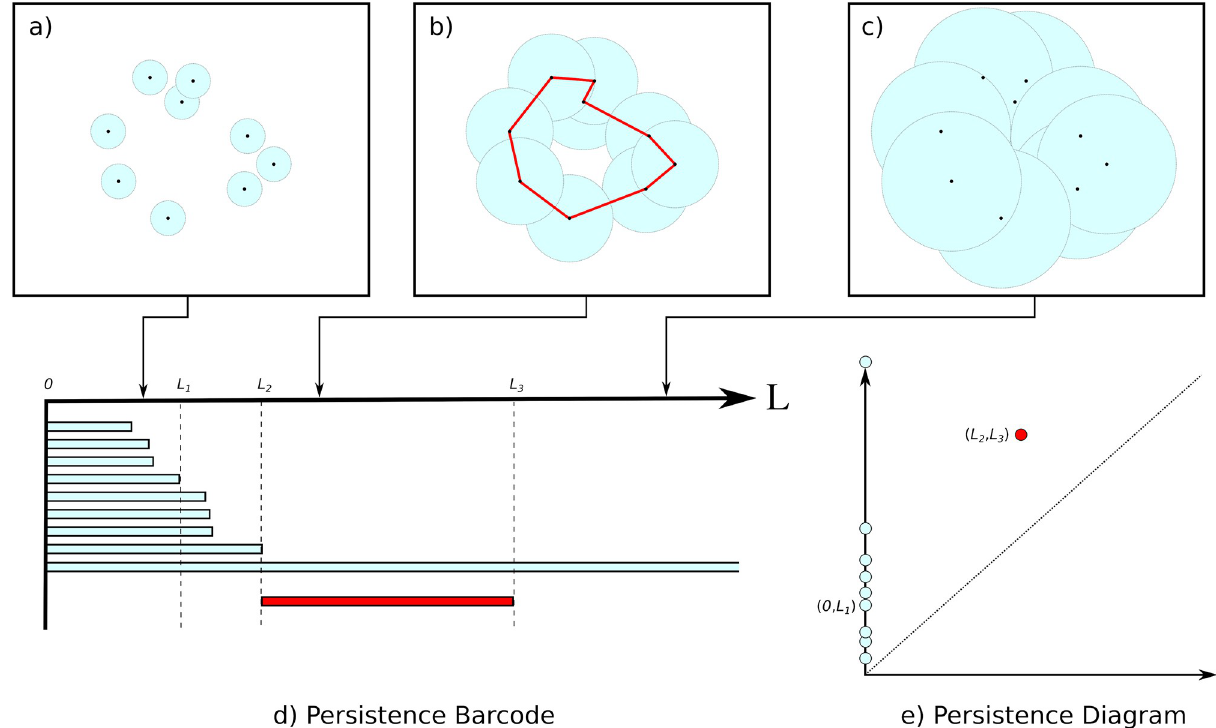
Fig 5. Persistence homology. Panels (a-c) illustrate the topology of a dataset changing as the length scale, L , is varied. (a) For small values of L , the balls (disks) are mostly disconnected; only 2 of the 9 intersect. (b) At an intermediate scale, all 9 balls intersect, forming a single connected component, giving rise to a loop. (c) At larger scales, there is a single connected component and no loop. (d) The progression illustrated in (a-c) is documented in the persistence barcode; the blue bars correspond to separate connected components, the ends of which corresponds to intersection (merge) events, e.g., at L = L 1 . The red bar corresponds to the loop, which forms at L = L 2 and which becomes filled in at L = L 3 . (e) The same information can be represented in persistence diagram in which the ( x , y ) coordinates of points correspond to the right and left ends, respectively, of each bar in the barcode.